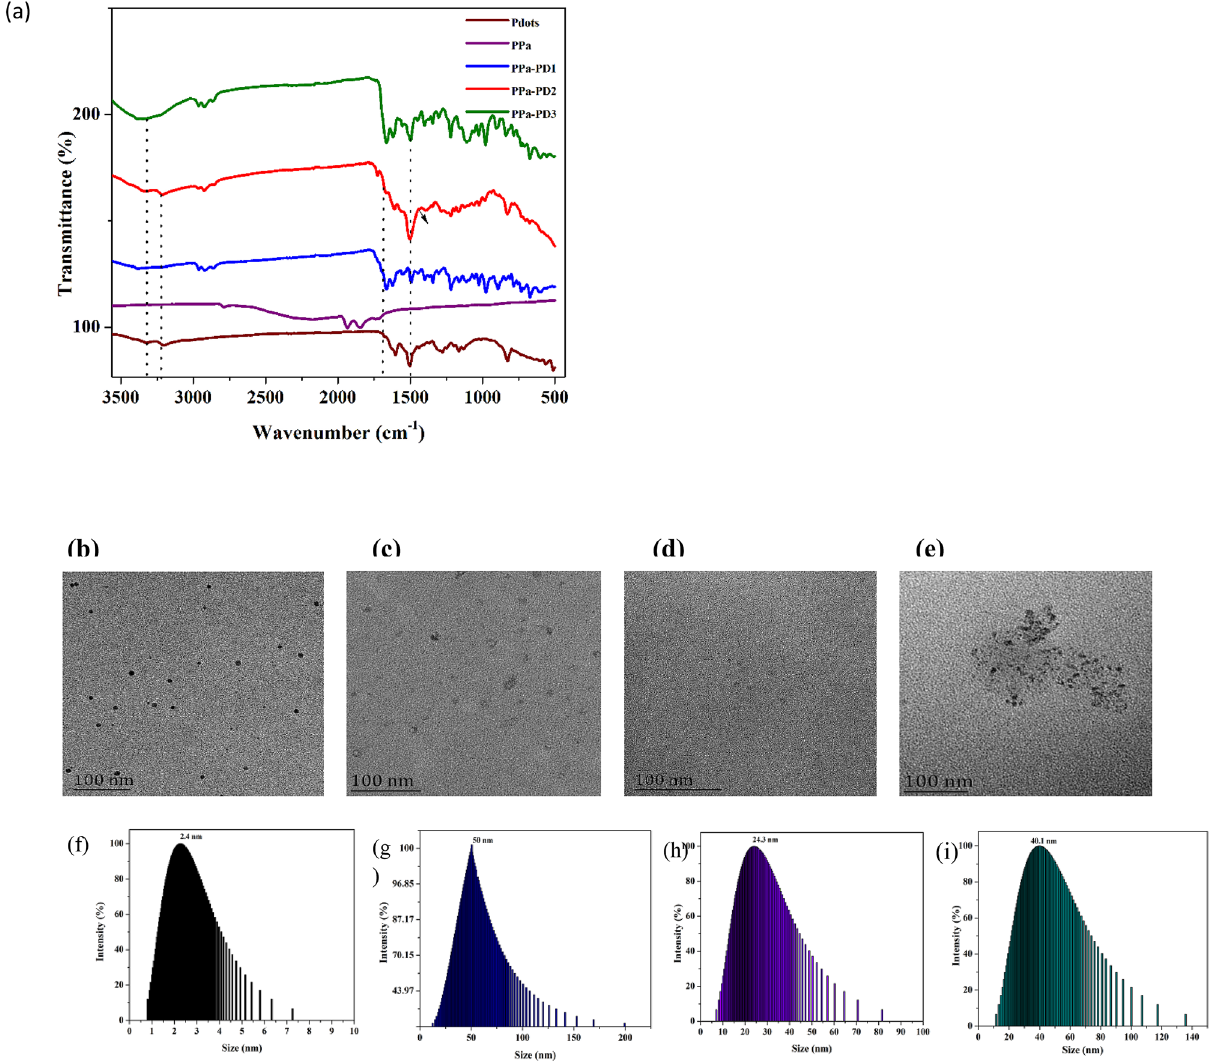
Figure 2. ( a ) FTIR of R-CPDs and conjugates. TEM images of ( b ) R-CPDs, ( c ) PPa-PD1, ( d ) PPa-PD2, ( e ) PPa-PD3. DLS of ( e ) R-CPDs, ( f ) PPa-PD1, ( g ) PPa-PD2, ( i )